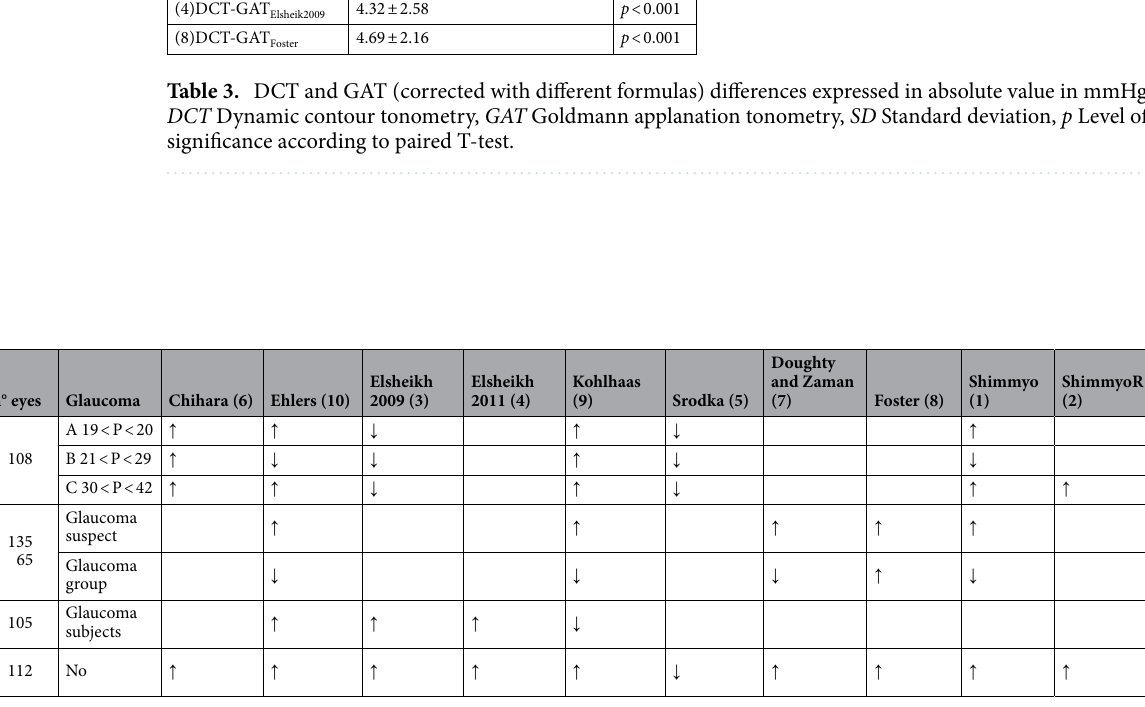
Table 4. Results provided by different authors and by the current study after the application of equations correction. ↑ = difference increase between the two methods (GAT and DCT) after correcction: poor usefull equation, ↓ = difference decrease between two methods (GAT and DCT) after correction: usefull equation. P = intraocular pressure, provided by GAT and expressed in mmHg. In Asejczyk-Widlika et al. 25 study subjects were divided in 3 groups (A, B, C) according to IOP values. In Ghee S et al. 24 study subjects were divided in two groups (glaucoma suspect and glaucoma